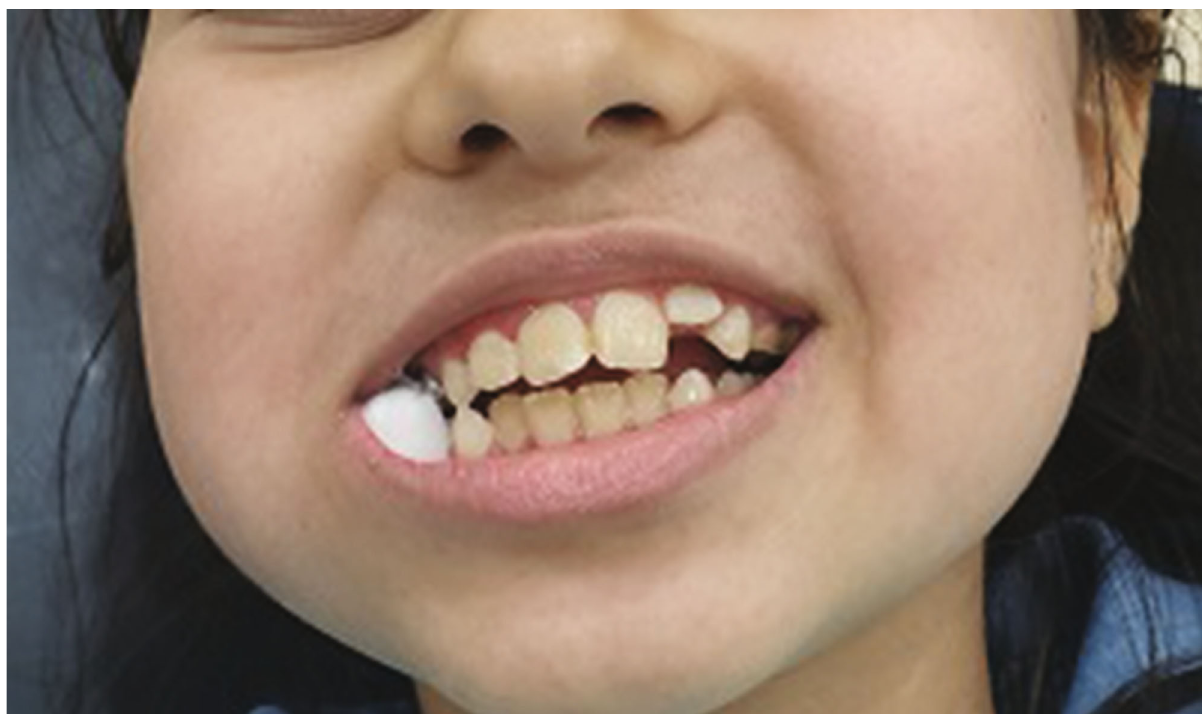
Figure 7: Eruption of anterior permanent